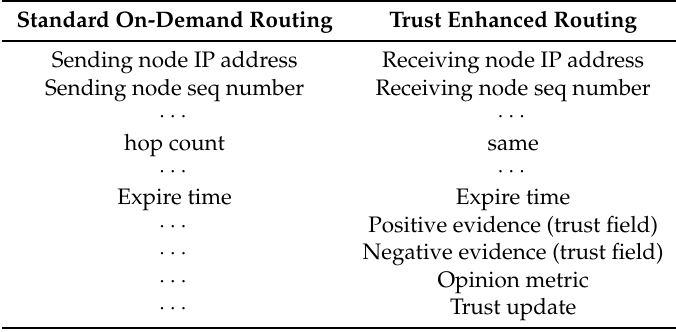
Table 1. Trust field extension added in proposed